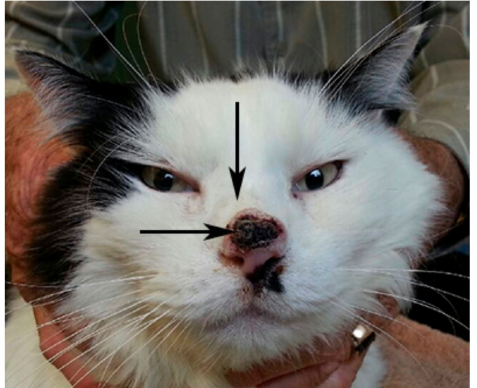
Figure 1. A recurrent invasive squamous cell carcinoma on the nasal planum (horizontal arrow) was adjacent the site of a biopsy (vertical arrow) from which high-grade lymphoma of the nasal cavity was